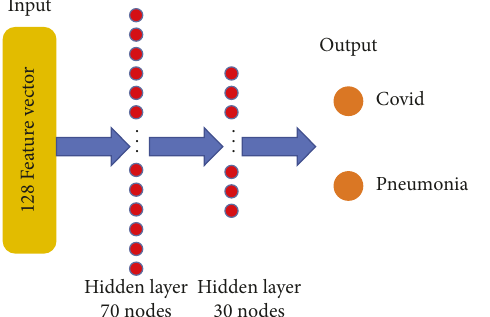
Figure 7: Employed multilayer neural network for binary classification.